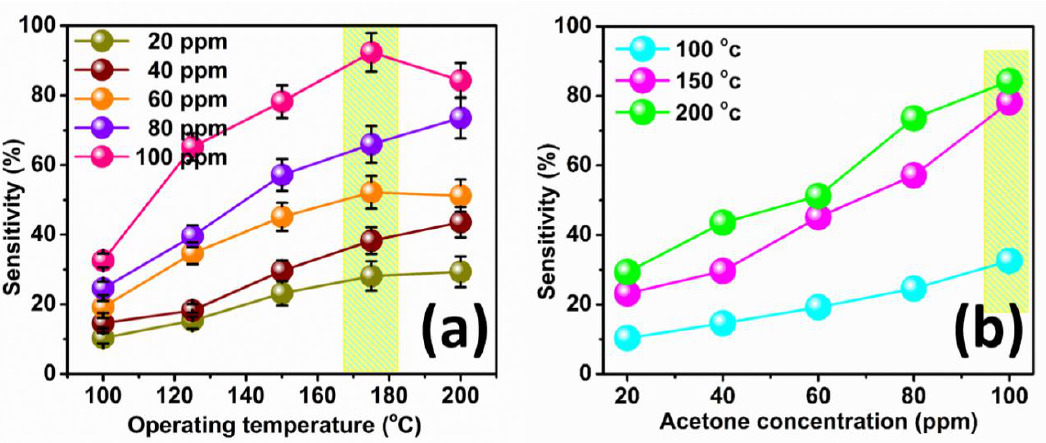
Figure 4. ( a ) Sensitivity vs. operating temperature plots and ( b ) sensitivity vs. concentration plots of ZnS QDs based acetone sensor.